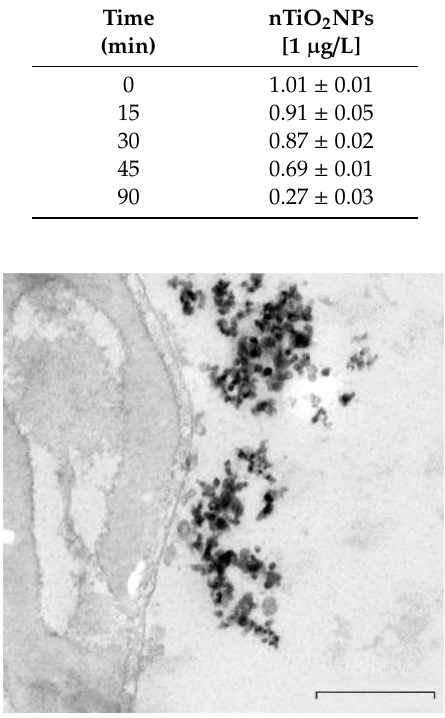
Figure 1. TEM micrograph showing the aggregation pattern of TiO 2 nanoparticles (bar 0.5 µm).